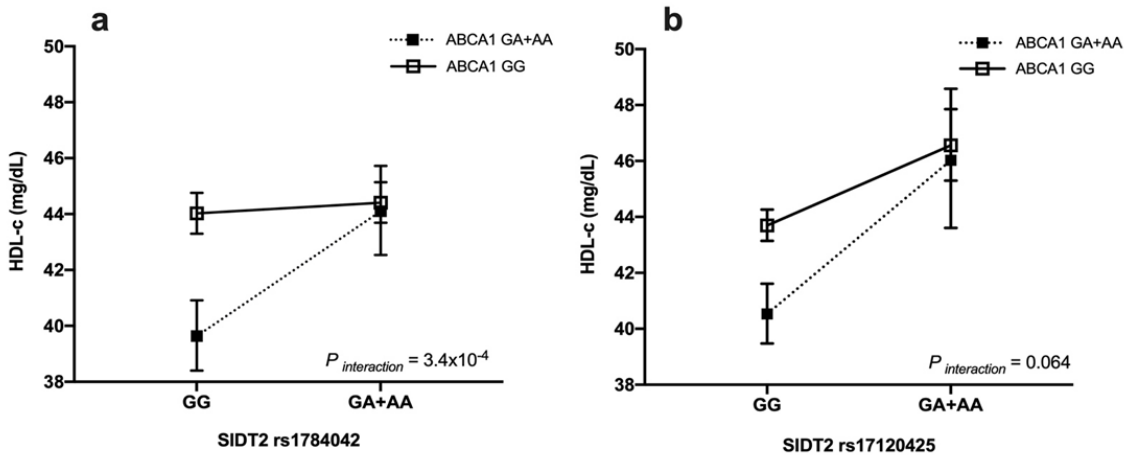
Figure 1. Interactions between polymorphisms of SIDT2 and ABCA1 on HDL-c levels in the total population. ( a ) SIDT2 – rs1784042 x ABCA1 – rs9282541 and ( b ) SIDT2 – rs17120425 x ABCA1